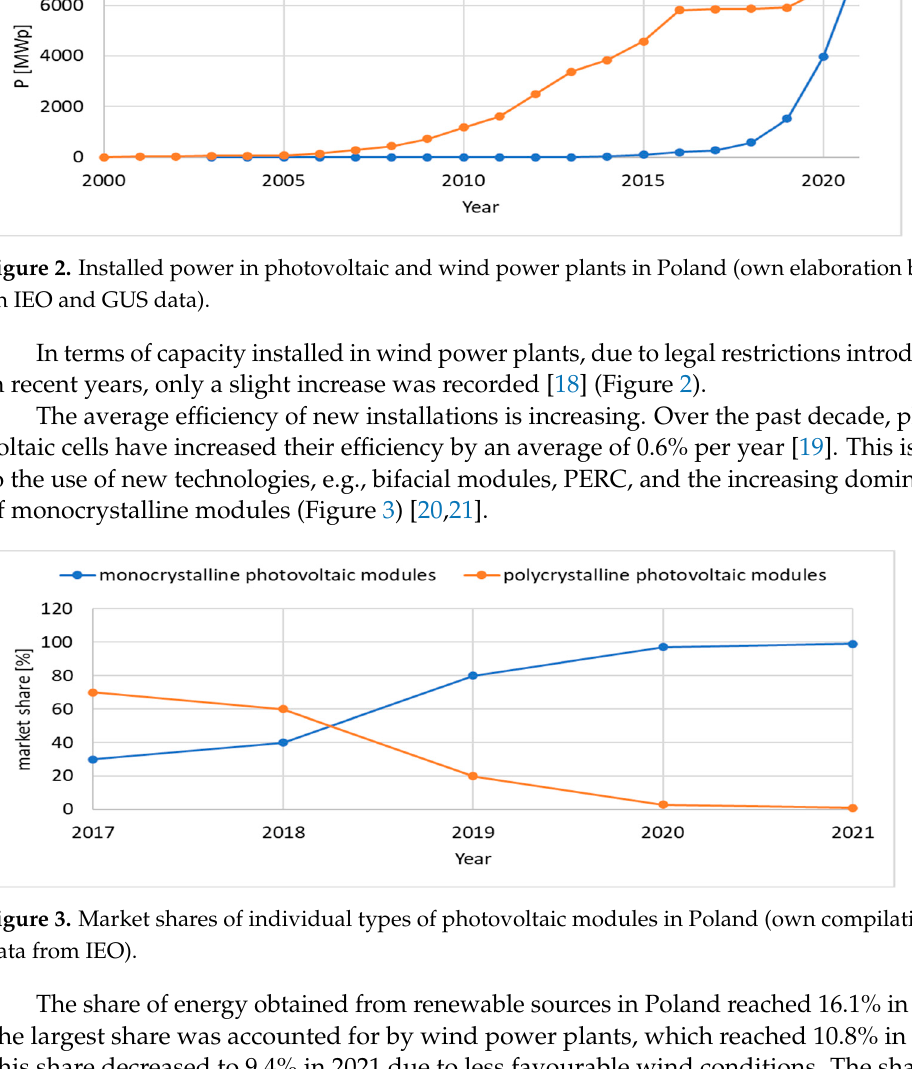
Figure 2. Installed power in photovoltaic and wind power plants in Poland (own elaboration based on IEO and GUS data).